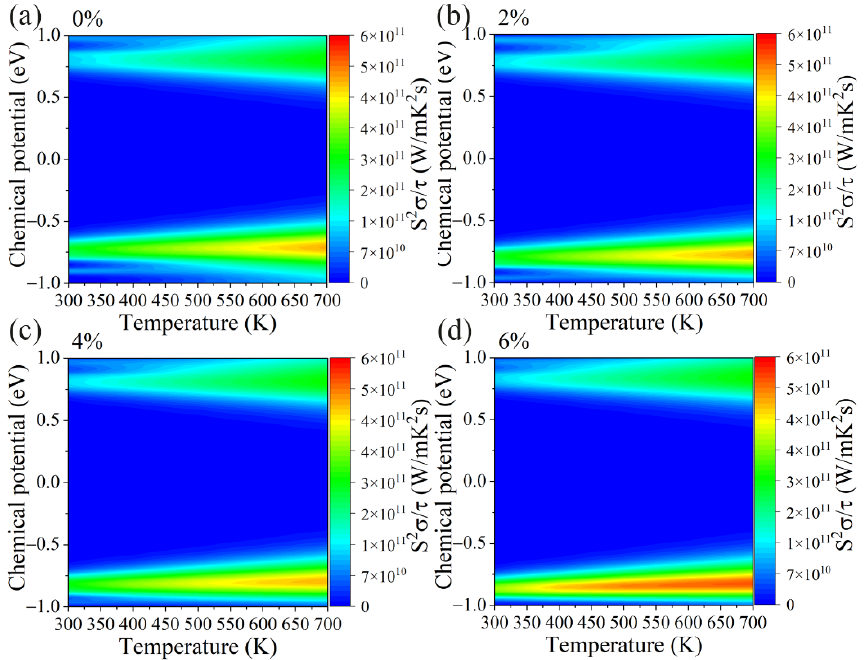
Figure 7. The contour map of the power factor divided by relaxation time (S 2 σ / τ ) with respect to chemical potential under different biaxial tensile strains of ( a ) 0%, ( b ) 2%, ( c ) 4% and ( d ) 6% for GeS 2 monolayer.